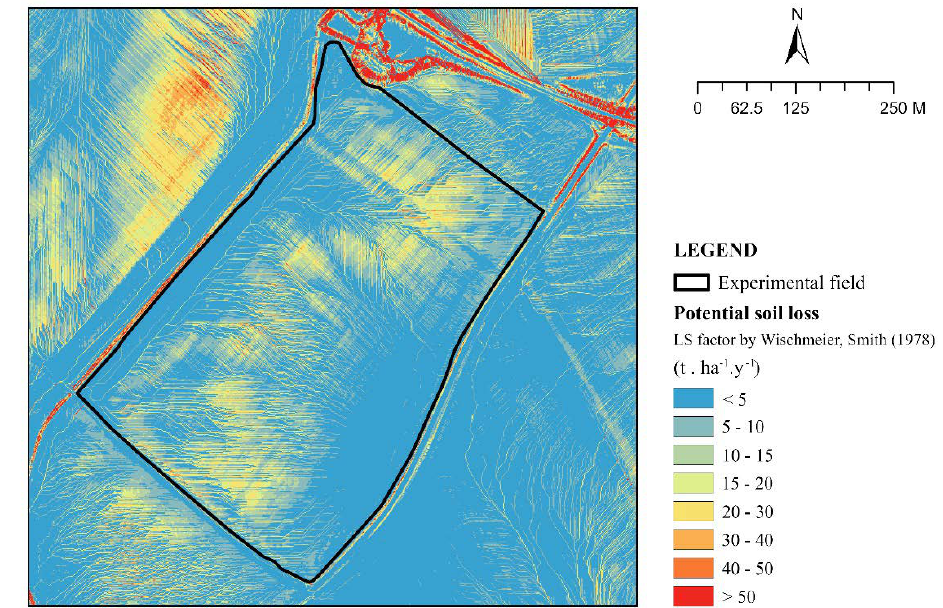
Figure 7. Potential yearly soil loss, determined by USLE equation.